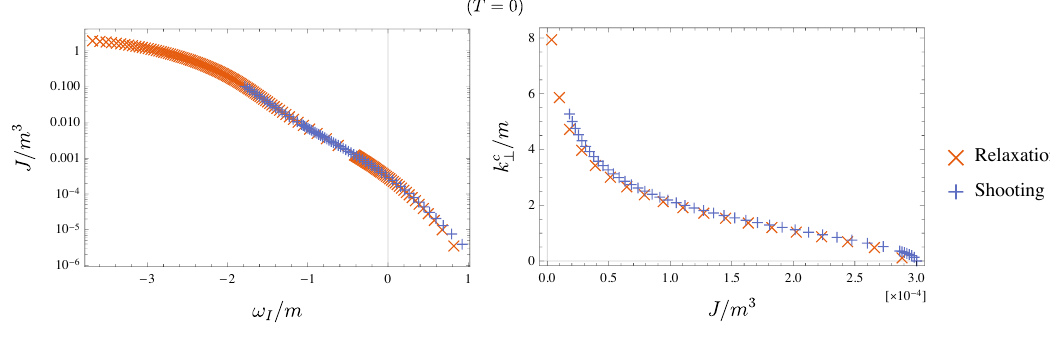
/m vs J/m 3 at T = 0 computed by the shooting c